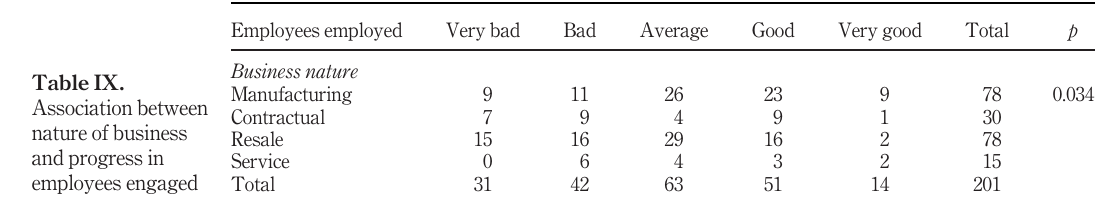
progress in turnover and nature of business